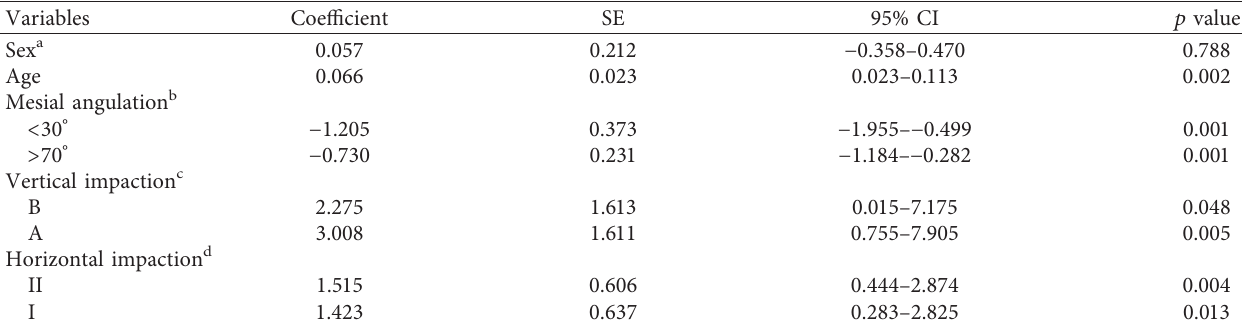
Table 3: Multivariable logistic regression of associations between distal caries in M2Ms and demographic/radiographic characteristics ( N �